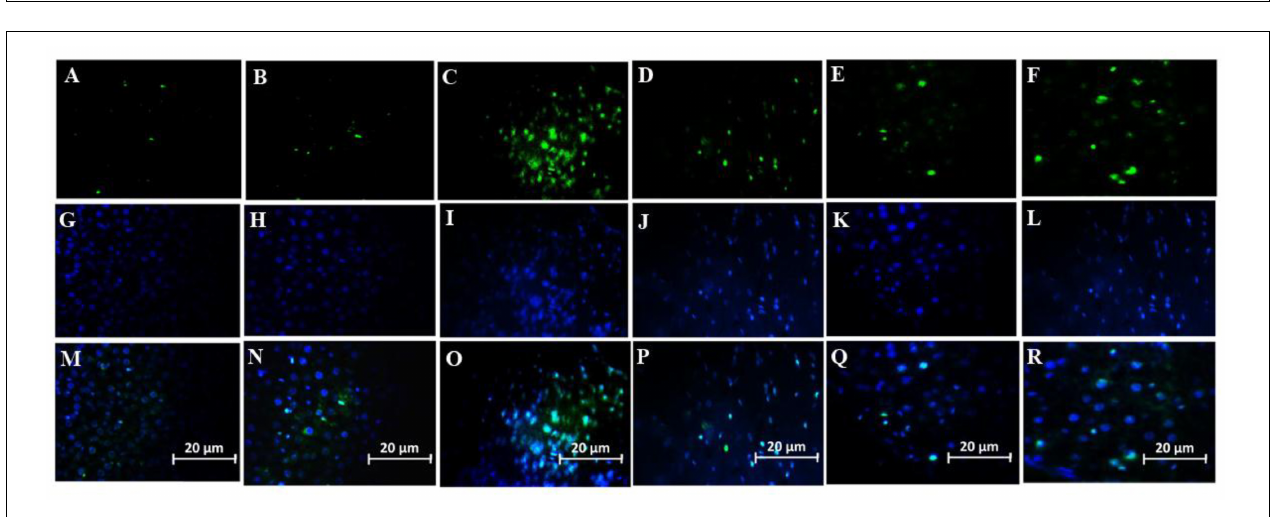
FIGURE 8 | Effect of SDF-1 and G-CSF on the amount of anti-IBA1 deposition in the cortex of all experimental groups: (A) (Control), (B) (Sham), (C) ( β A), (D) (G-CSF), (E) (SDF-1), (F) (G-CSF&SDF-1): DAPI (G–L) , Merge (M–R)